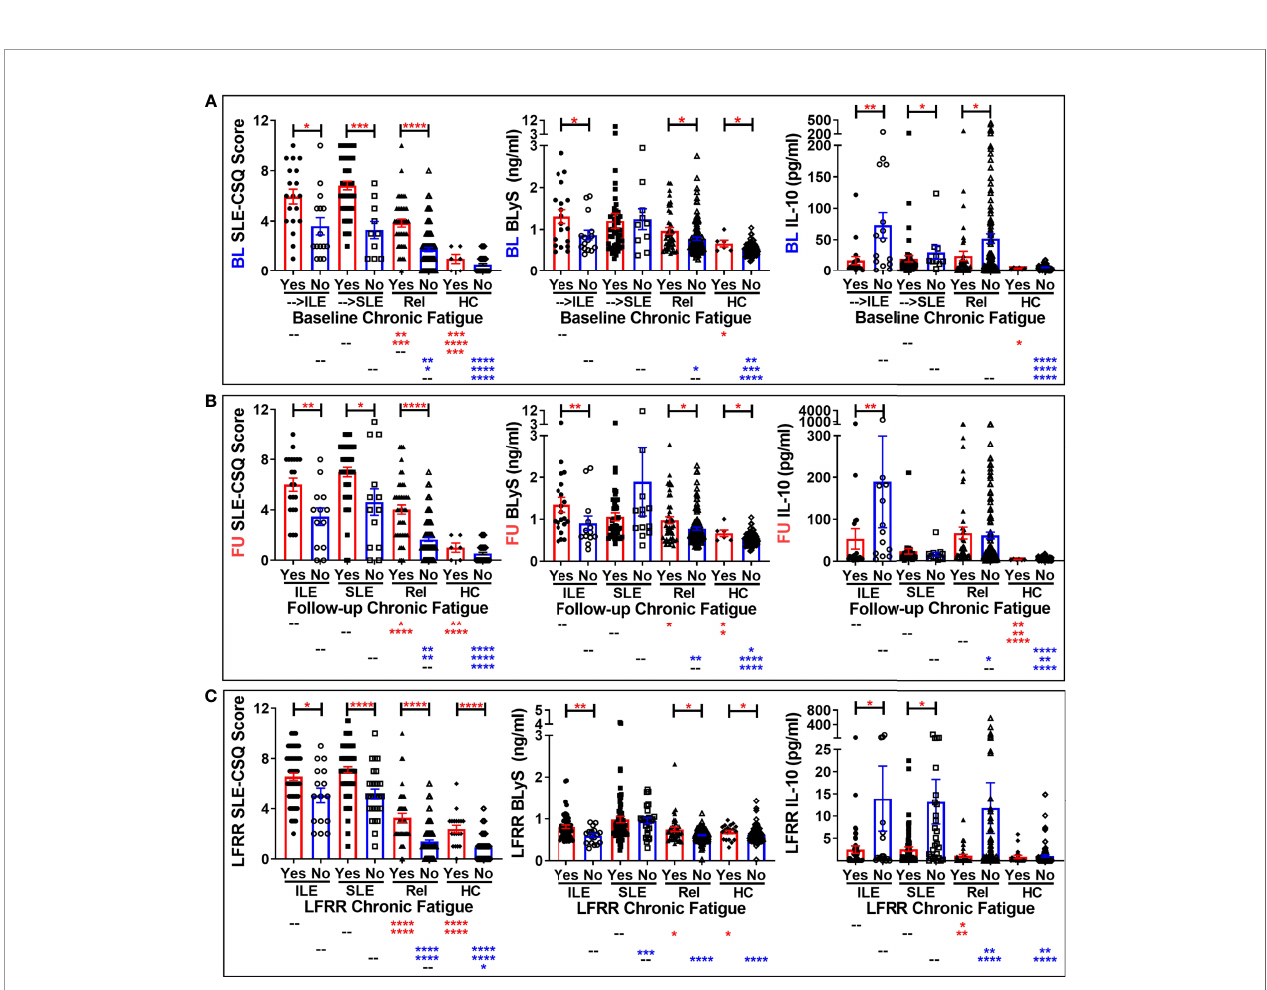
FIGURE 2 | Altered SLE-CSQ scores and BLyS and IL-10 levels associated with reported chronic fatigue in lupus relatives prior to and after disease transition in the LAUREL and LFRR con fi rmatory cohorts. Lupus relatives who developed ILE (ILE), transitioned to SLE (SLE), or remained clinically unaffected (Rel) vs. matched, unaffected healthy controls (HC) who did (Yes) or did not (No) report chronic fatigue on the LFRR questionnaire were evaluated for SLE-CSQ scores ( 1 st column ), plasma BLyS levels ( 2 nd column ), and plasma IL-10 levels ( 3 rd column ) in (A) LAUREL cohort at baseline (pre-transition), (B) LAUREL cohort at follow-up (post-transition), and (C) LFRR con fi rmatory cohort (post-transition). Mean ± SEM. **** p<0.0001 ; *** p<0.001 ; ** p<0.01 ; * p<0.05 by Kruskal-Wallis with Dunn ’ s multiple comparison.